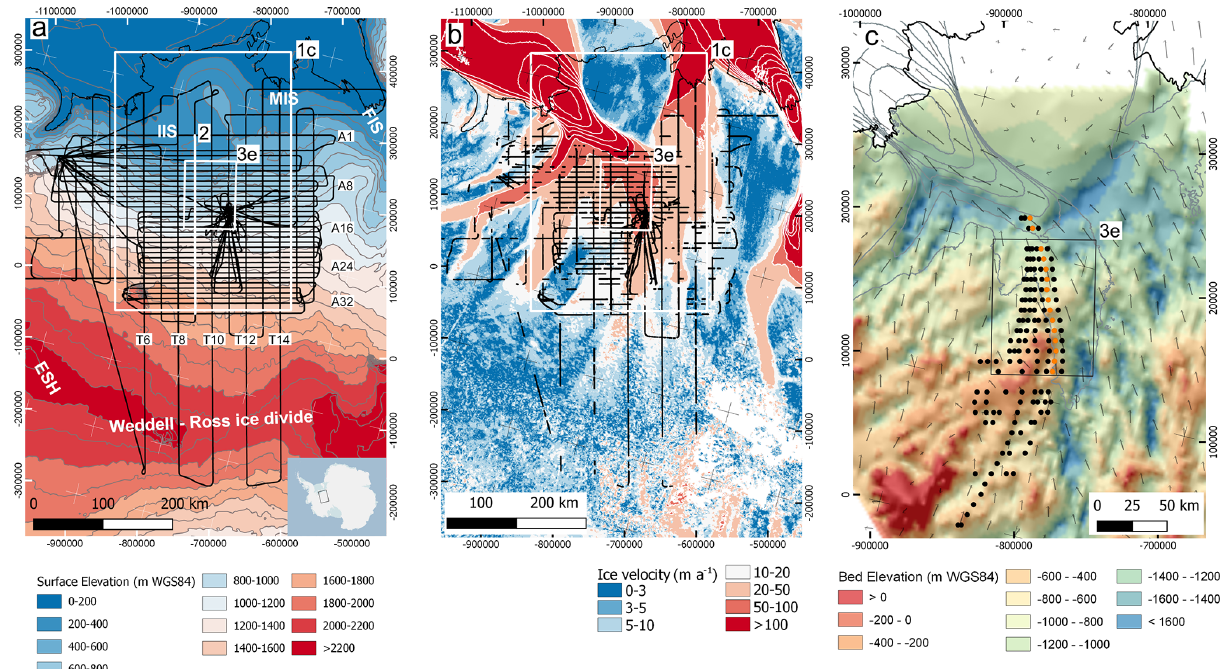
Figure 1. (a) Ice-penetrating radar survey flights over the catchments of the Institute and Möller ice streams (thick black lines), overlain on ice surface elevation (m WGS84) (Bamber et al., 2009). The thin black line in all panels is the MODIS grounding line (Bohlander and Scambos, 2007). The grey lines are ice surface elevation contours at 100m intervals. The Möller Ice Stream (MIS), Institute Ice Stream (IIS), Foundation Ice Stream (FIS), Weddell–Ross ice divide, and Ellsworth Subglacial Highlands (ESH) are indicated. The white boxes indicate extents of (c) and Fig. 3e. The white line is survey tie line 9, shown in Fig. 2. The inset in (a) shows the Antarctic location of (a)–(b) . (b) Observations of deep-ice unit R1 in radargrams across the study area (thick black lines) overlain on MEASURES ice velocity (Rignot et al., 2017). The white lines are velocity contours at 50ma − 1 intervals. Gaps in observations are either where data were not acquired or where the deep-ice unit could not be identified in the radar data (e.g. because of signal attenuation). The white boxes indicate extents of (c) and Fig. 3e. (c) Folded deep ice beneath IIS, relative to basal topography (Ross et al., 2012) and surface ice flow (Rignot et al., 2017). The location of fold axis peaks, identified in radargrams, are represented by black and orange circles, the latter colour denoting the position of the fold with the “hand-shaped” reflection (Fig. 3d) at its core. The black box defines the limits of Fig. 3e. The thin grey lines are 50m contours of MEASURES ice velocity (Rignot et al., 2017). The arrows show the direction and magnitude of the ice flow (Rignot et al.,